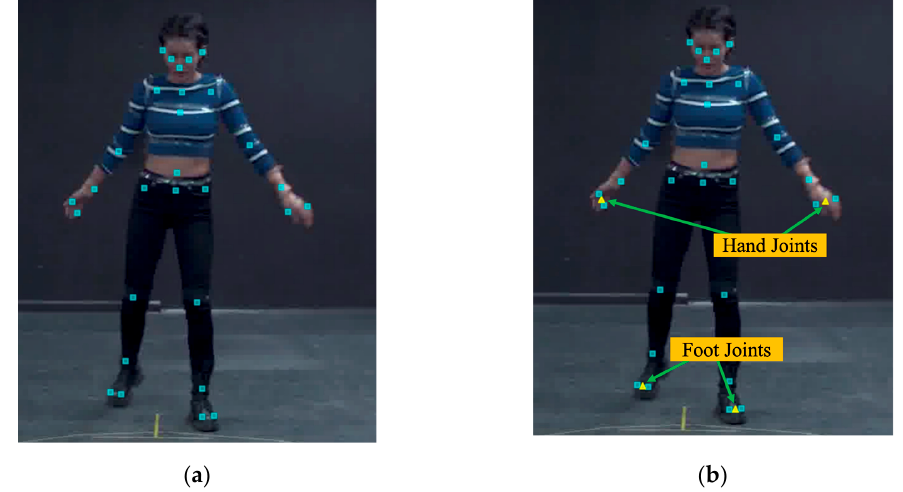
Figure 11. Extended K-pop dance video dataset of hand and foot joints: ( a ) K-pop dance video dataset’s defined joints; ( b ) generated joints that match the hands and feet of DyWHSE.